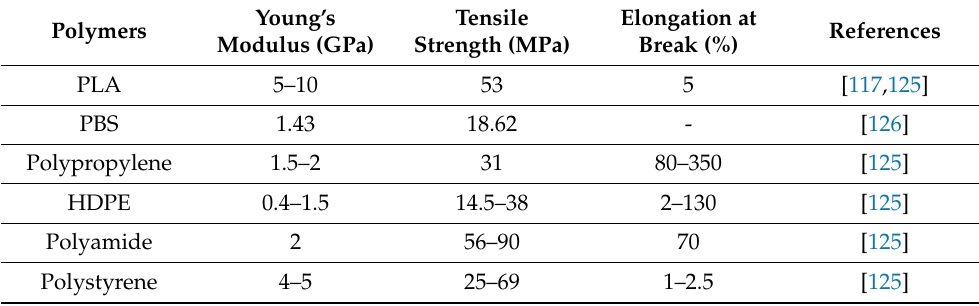
Table 5. Comparison of mechanical properties of PLA and PBS with synthetic